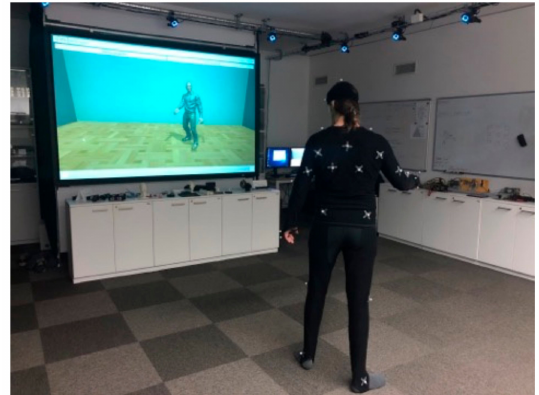
Figure 4. Participant using projection